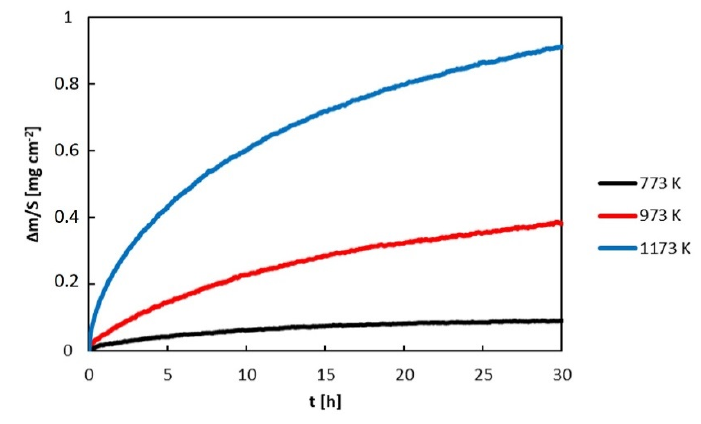
Figure 9. Mass gain of the Al 71 Co 29 alloy during isothermal oxidation in flowing synthetic air.